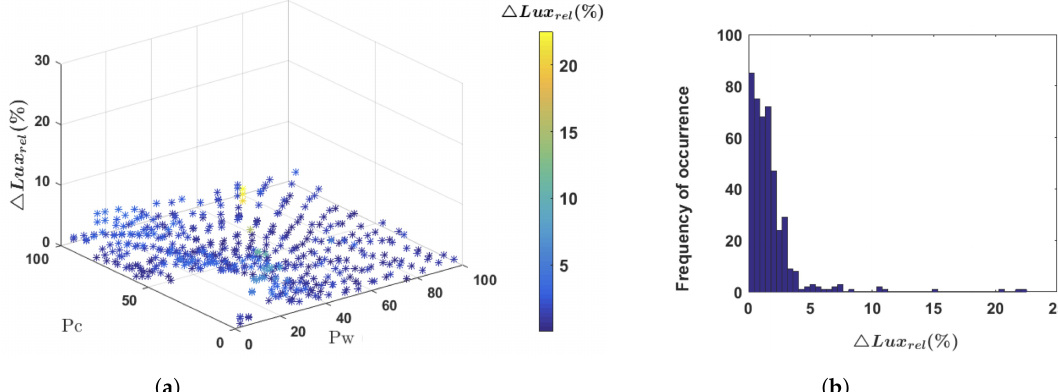
Figure 10. Results of the testing phase: ( a ) distributions of the relative percentage differences of parameter between the expected and measured illuminance as a function of the input power for the test point; ( b ) Histogram of the relative percentage differences calculated for the test point of the two LED light sources.